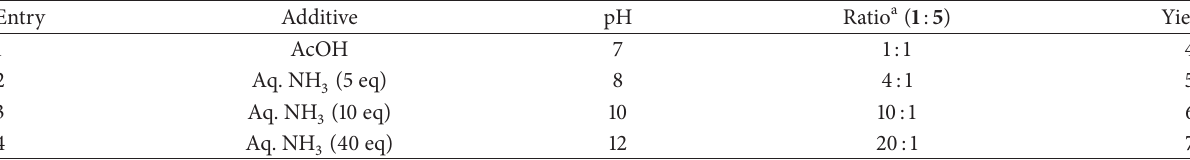
Scheme 6: Overreductive amination. Table 3: pH of the reaction mixture.